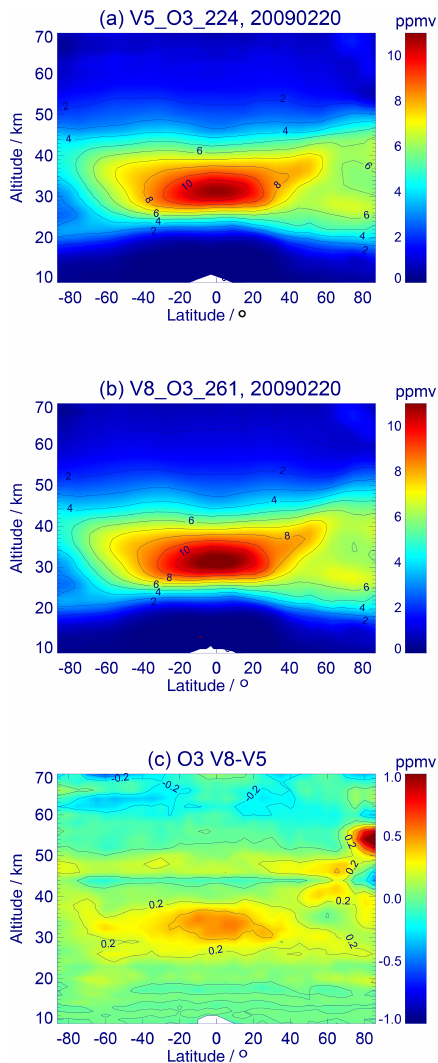
Figure 5. Global ozone distributions on 20 February 2009, MI- PAS version V5_O3_224 (a) and version V8_O3_261 (b) . Panel (c) shows the differences.